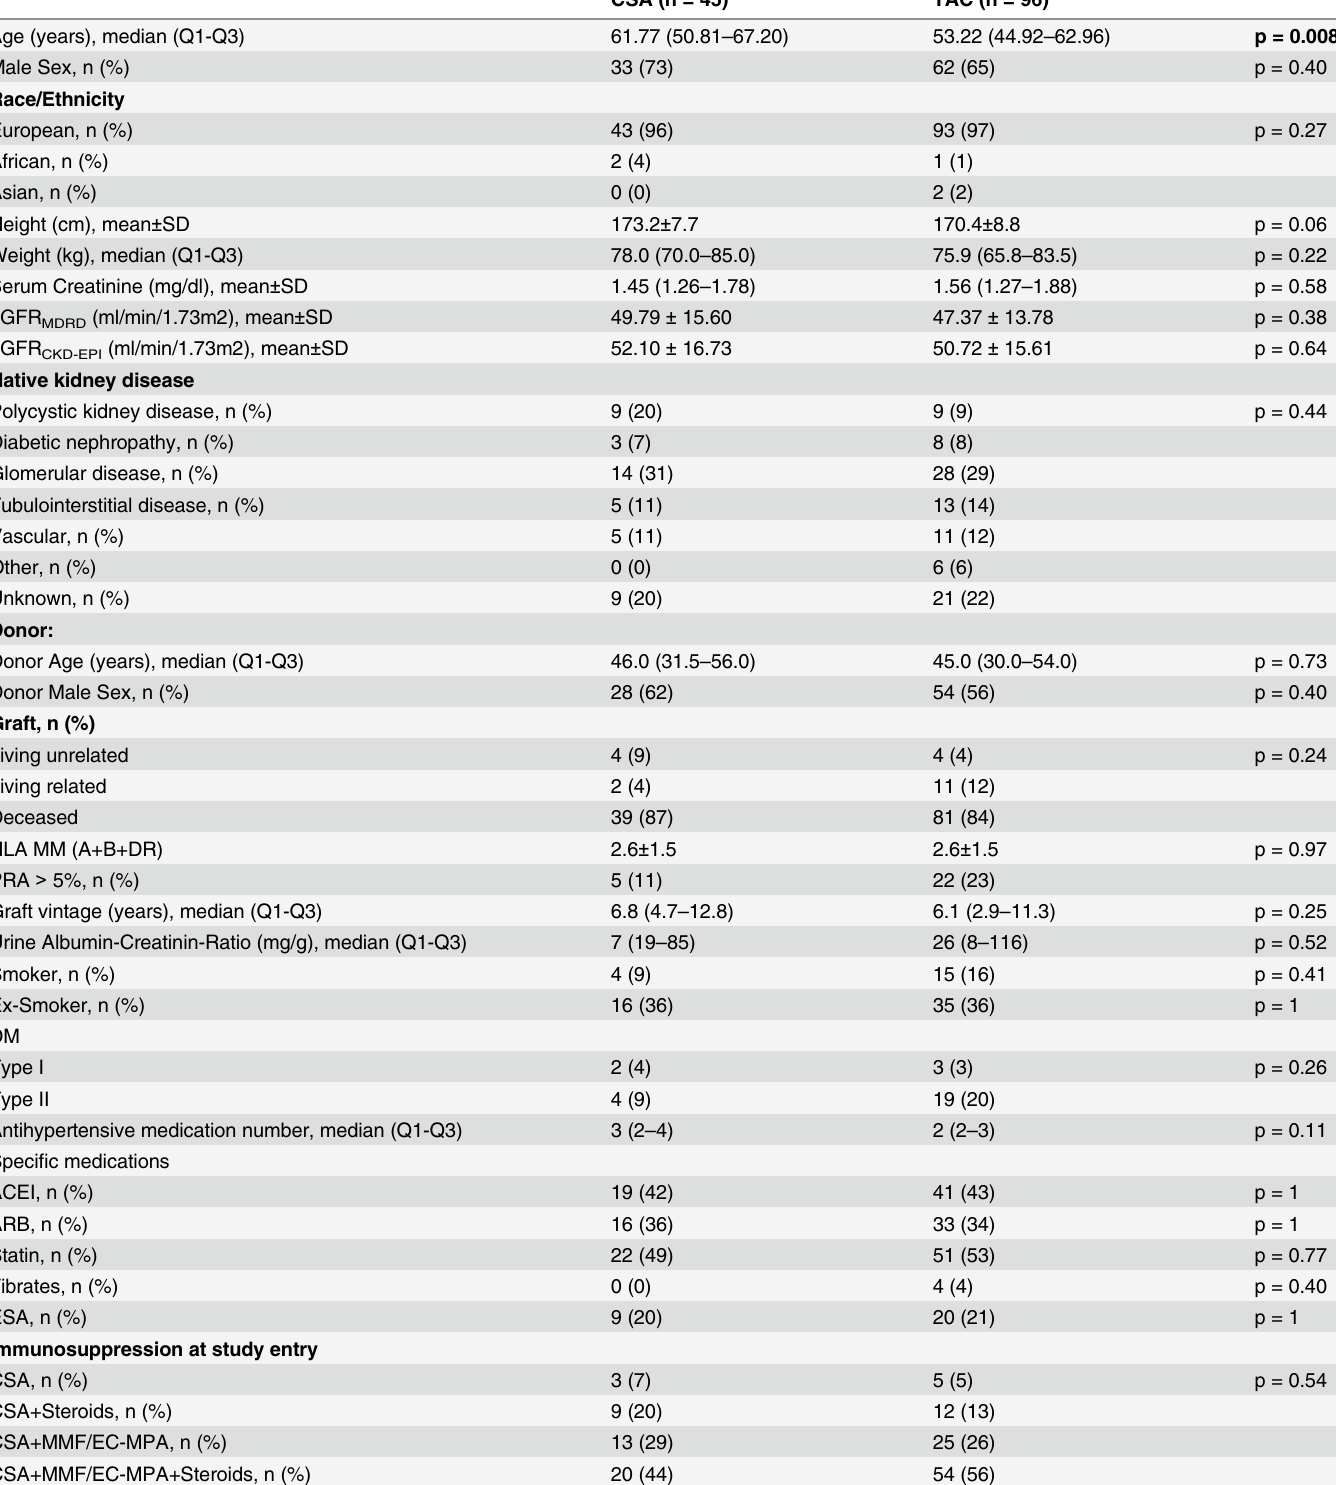
Table 1. Baseline Demographics for Patients Randomized to CSA and